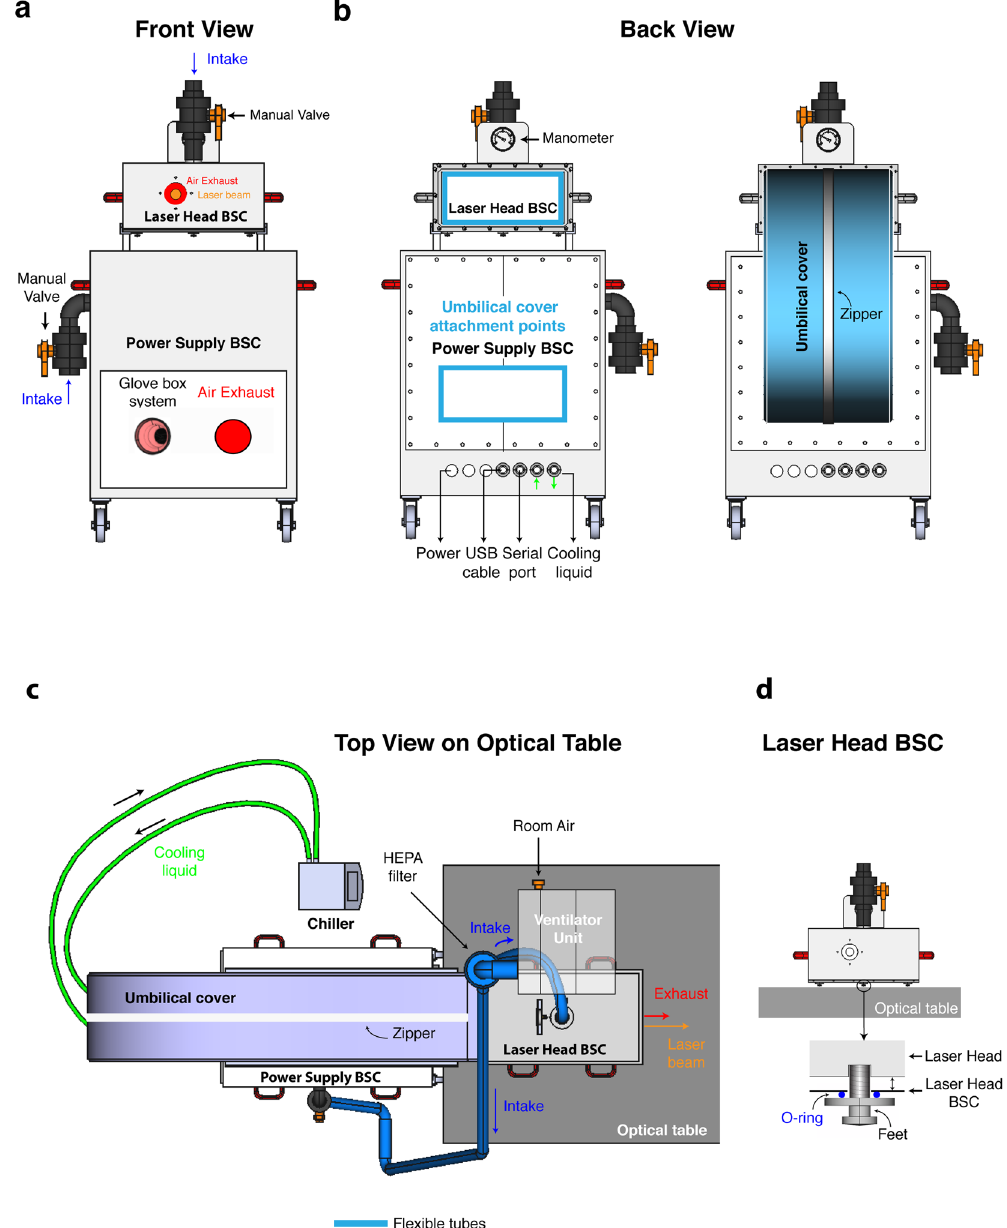
Figure 2. Class I Biosafety Cabinets for laser head and power supply of a Ti-Sapphire laser. ( a ) Front view. The laser head and power supply BSC are outfitted with a manual valve for the intake of air from a ventilator unit that maintains a positive pressure within each of them. The laser head BSC has built-in an opening that allows air exhaust and the exit of the laser beam. The power supply BSC has built in a glove box system to allow the access to the controls and an air exhaust. For convenience the laser head can rest on a rail of the power supply BSC for moving both parts within the BLS3 laboratory. ( b ) Back view. The power cables of the laser components are connected to a power bar and its cable pass through the wall of the power supply BSC by a thermos-retractable airtight cable gland before being plugged into a wall socket. The same type of pass-through connection is used to exit a USB and serial port cable from the power supply BSC to connect to a spectrometer and the computer piloting the microscope, respectively. A push-to-connect fitting housed within an airtight thermo-retractable cable gland does the connection of the laser head to the chiller by passing through the wall of the power supply BSC. ( c , d ) The laser head BSC sits on top of an optical table through the use of 3 custom made self-sealing feet that transverse the BSC to prevent its deformation overtime due to the weight of the laser